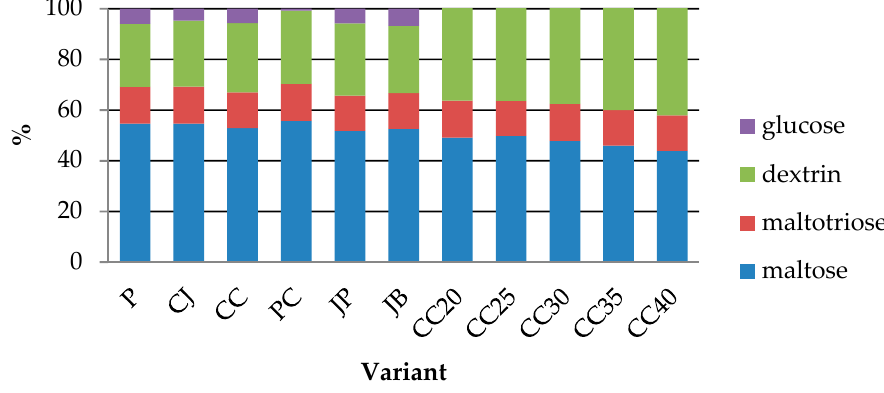
Figure 1. The share of individual sugars in the carbohydrate profile of the wort produced.